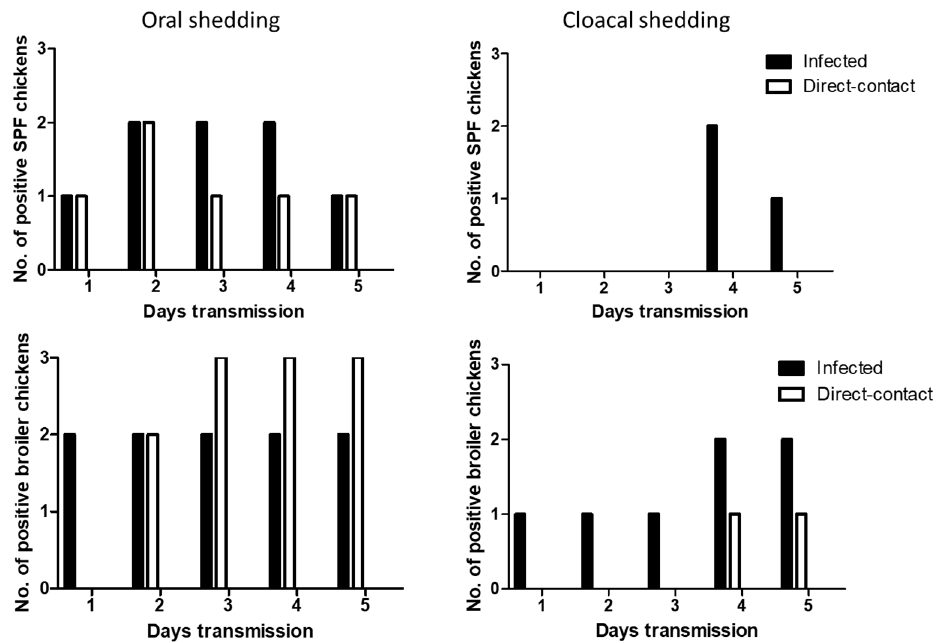
Figure 5. Transmission of H7N9 in SPF and broiler chickens. Three infected birds with each virus (10 7 pfu/mL) and three contact exposure birds (naïve birds) were placed in an isolator in one day apart. From following day, swab samples were collected daily up to 5 days for virus